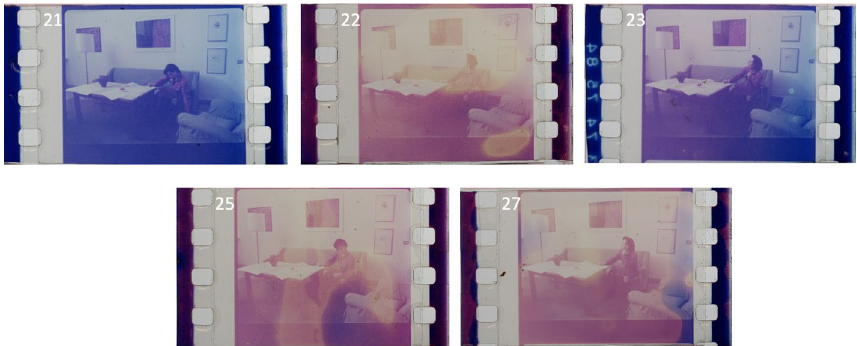
Fig. 1 Optical images of the dataset selected for this experiment: frames number 21, 22, 23, 25, and